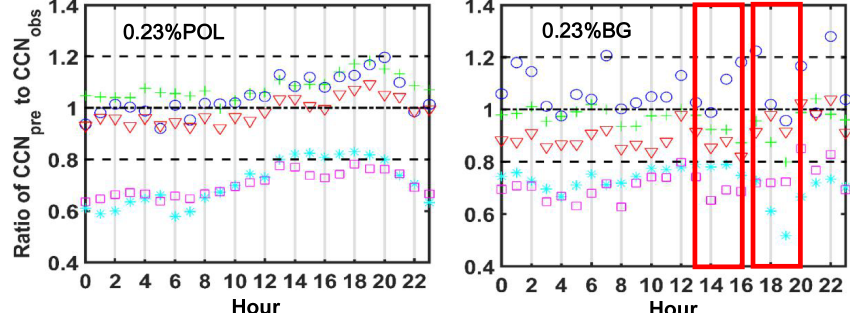
Figure 8. Diurnal variations in the ratio of predicted-to-measured N CCN at a supersaturation level of 0.23% under background (BG) and polluted (POL) conditions. The following symbols are used to define the schemes displayed: + INT–BK internal mixture, bulk composition; ◦ INT–SR internal mixture, size-resolved composition; ∗ EXT–BK external mixture, bulk composition; (cid:3) EXT–SR external mixture, size- resolved composition; (cid:79) EI–SR external mixture, sulfate, nitrate, SOA, and aged BC internally mixed, and POA and fresh BC externally mixed, size-resolved